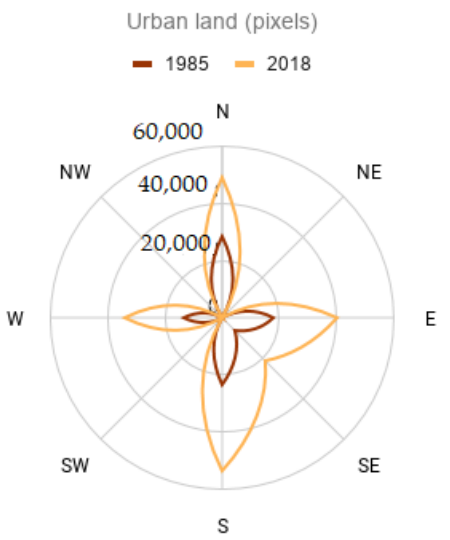
Figure 5. Urban land classification obtained from TM (L5), ETM+ (L7), and OLI (L8) imagery from 1985, 2012, and 2018, respectively. Resultant temporal urban sprawl from 1985 to 2018 in the TTC area.